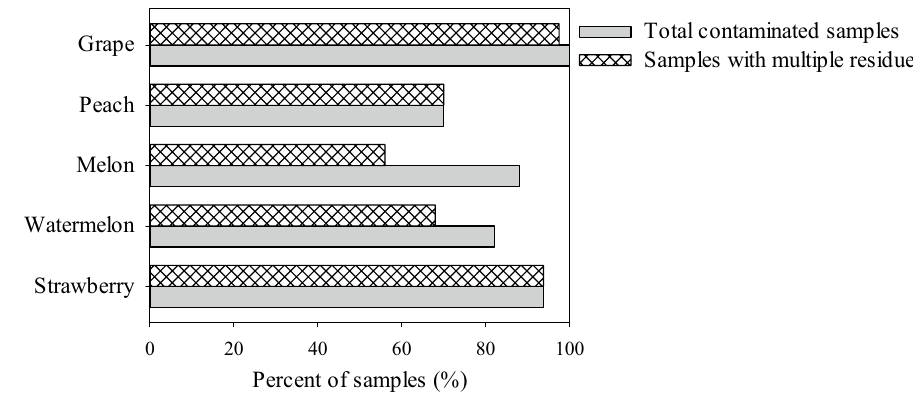
Figure 1. Percent of contaminated samples in strawberries, watermelons, melons, peaches, and